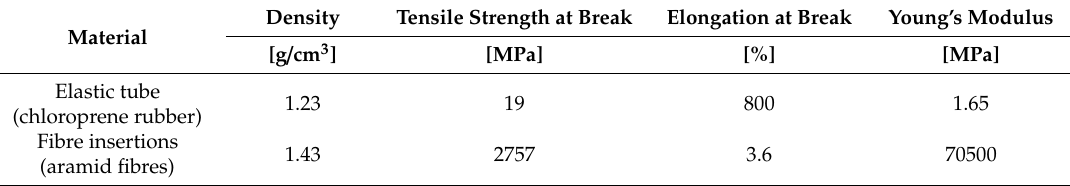
Table 1. Characteristics of the materials of a pneumatic muscle.